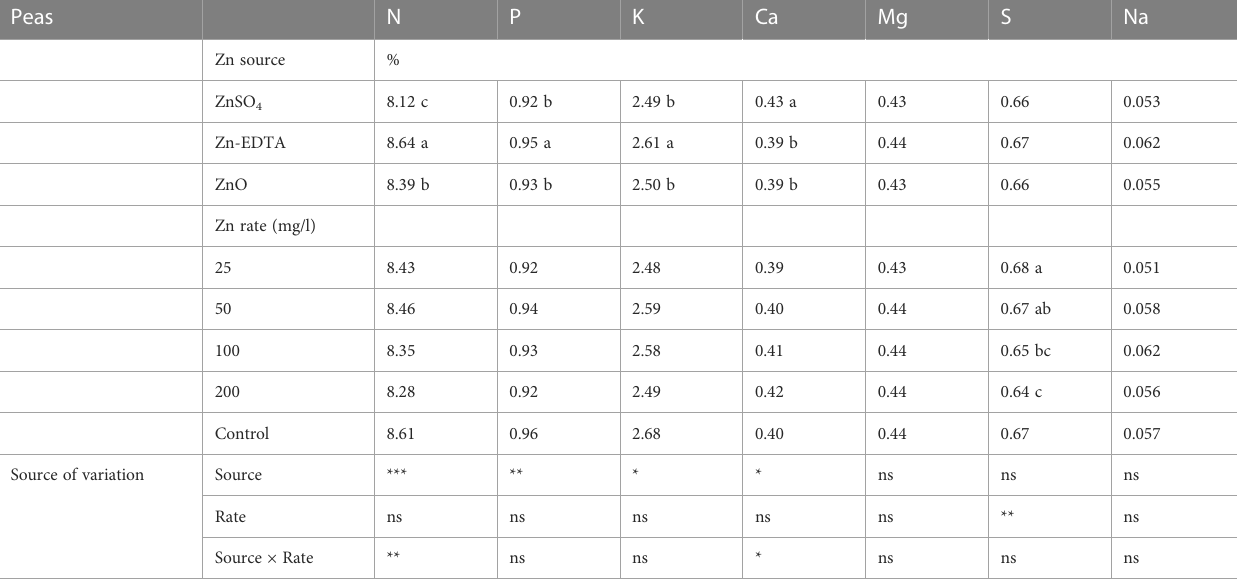
TABLE 3 Effects of seed soaking with different Zn sources and rate on the macromineral pro fi le of pea microgreens. 1 Peas N P